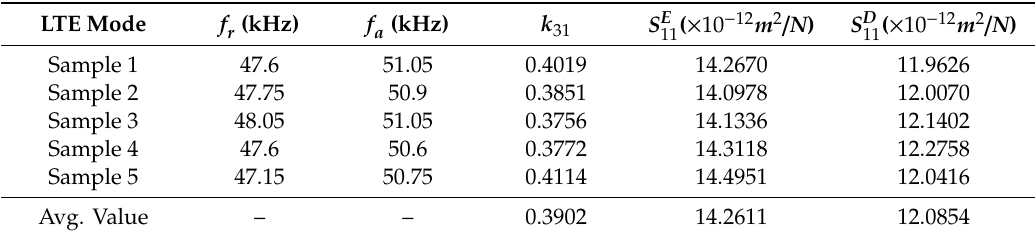
Table 6. Resonant and anti-resonant frequencies and the converted material constants in length thickness extension (LTE) mode.